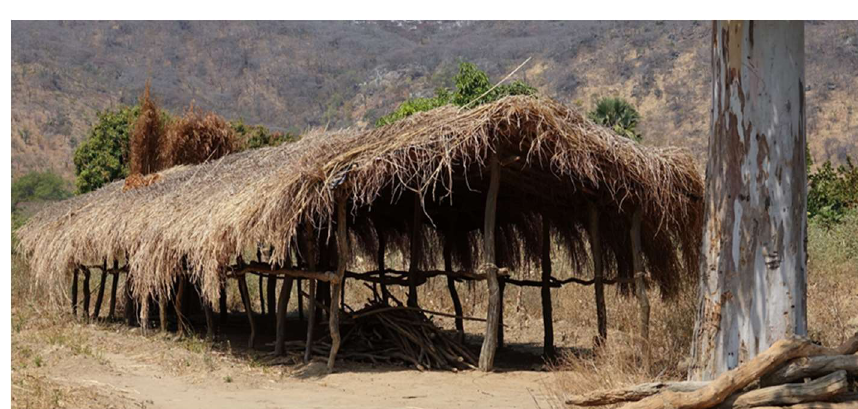
Figure 6. Barn for burley tobacco curing (Photo by Susan Ngwira, 9 August 2017).